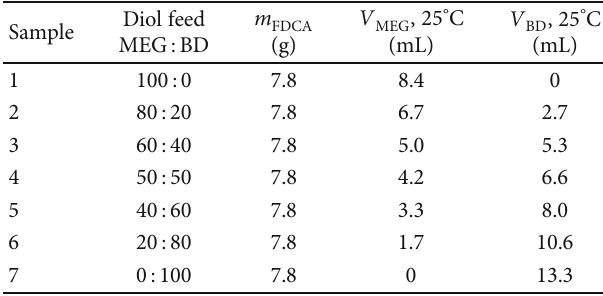
Figure 1: Schematic overview of the synthesis of PEF-co-PBFs by two-step melting polycondensation. Table 1: The preparations of copolymer